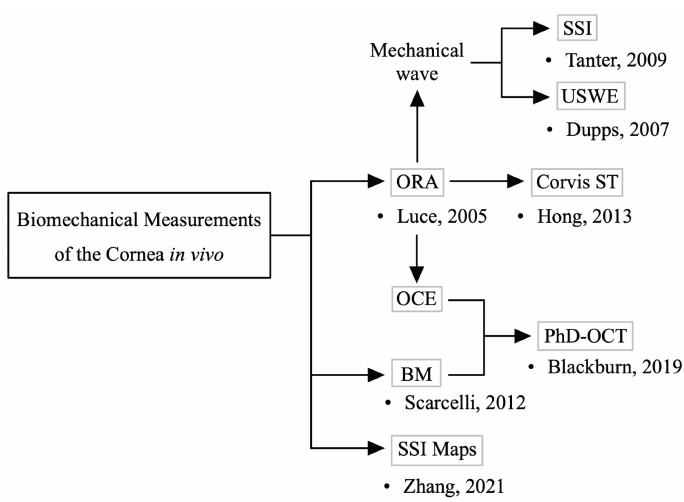
Figure 1. Development of in vivo corneal biomechanical measurements. Initial techniques for assessing the corneal mechanical characteristics utilized air puffs (e.g., ocular response analyzer (ORA)) [14]. Later, less destructive corneal deformation techniques, such as ultrasound (mechanical waves) [16,17], were developed. In recent years, new technologies such as brillouin microscopy (BM) [18] have emerged. Some commercial devices (ORA, corneal visualization Scheimpflug technology (Corvis ST)) are now used in clinical